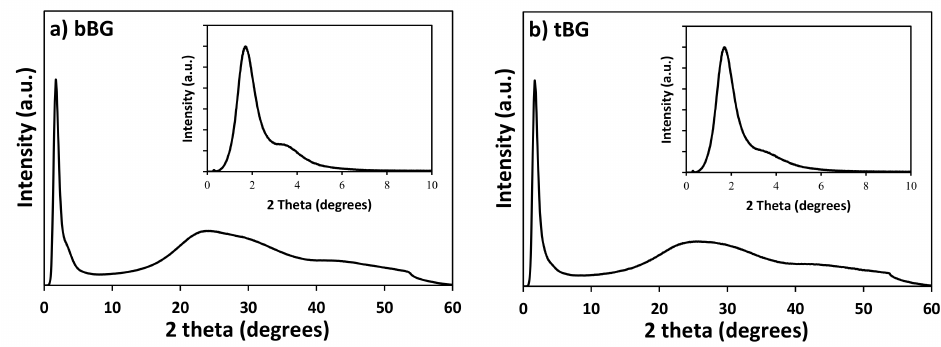
Figure 3. Wide-angle and low-angle XRD patterns of ( a ) bBG and ( b )